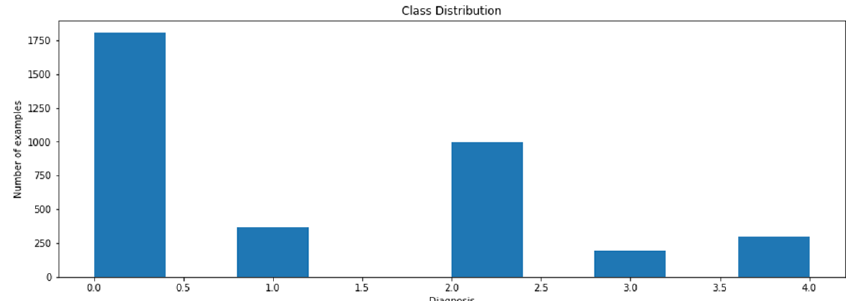
Figure 5. Class distribution.